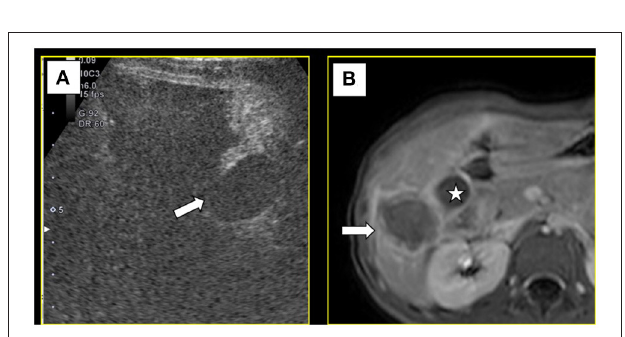
FIGURE 3 | (A) Microwave antenna( ↓ ) punctured at the feeding artery and the hyperechoic caused by ablation( ← ). (B) After ablation of the feeding artery, contrast-enhanced ultrasound showed no blood supply ( → ) inside the tumor.